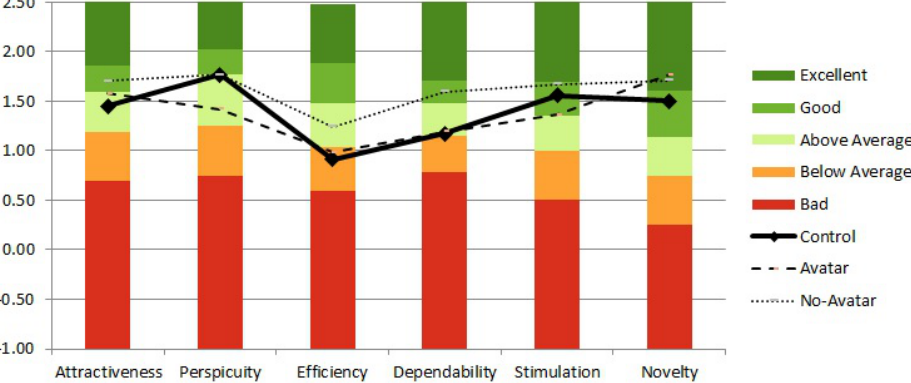
Figure 5. Reported user experience across six UEQ factors as a function of the experimental